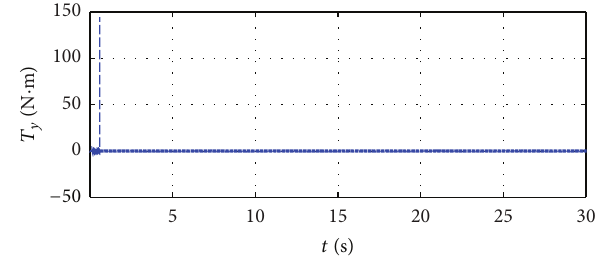
Figure 15: Torque in 𝑦 direction. This torque is applied to the sphere in the 𝑥 direction to control the position of the ball by means of changing beta in 𝑦